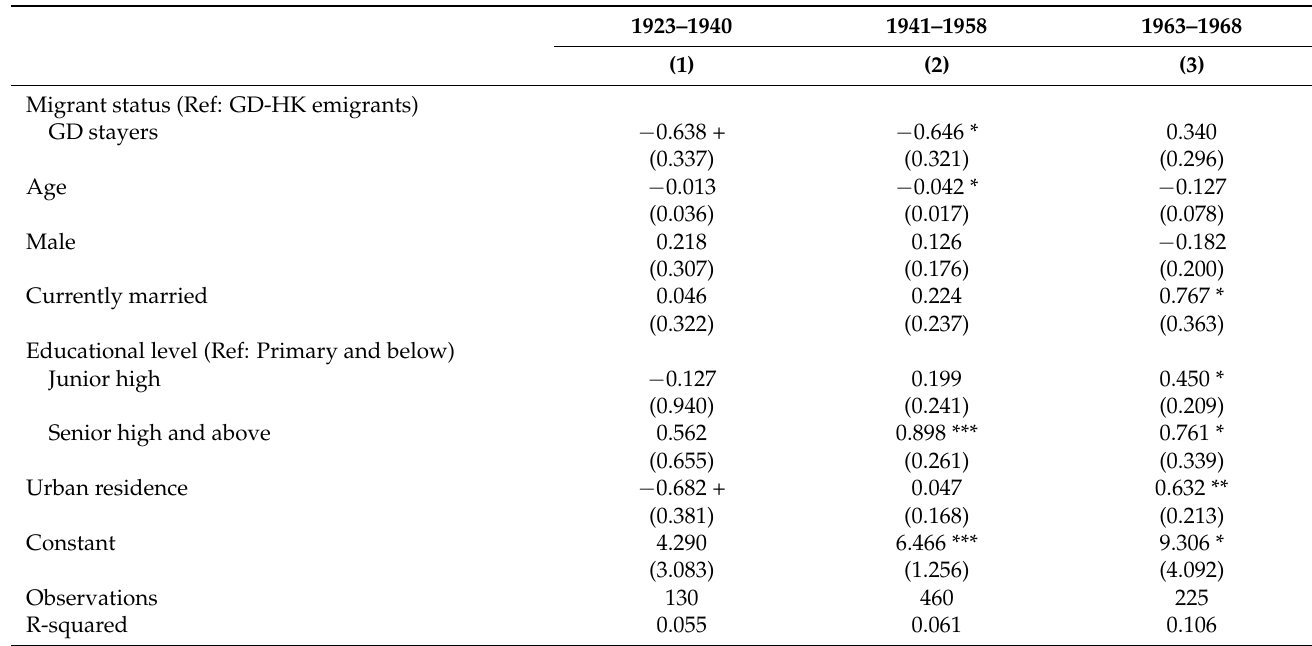
Table 2. OLS regressions of immediate word recall for different birth cohorts (the migrant–stayer comparisons approach).